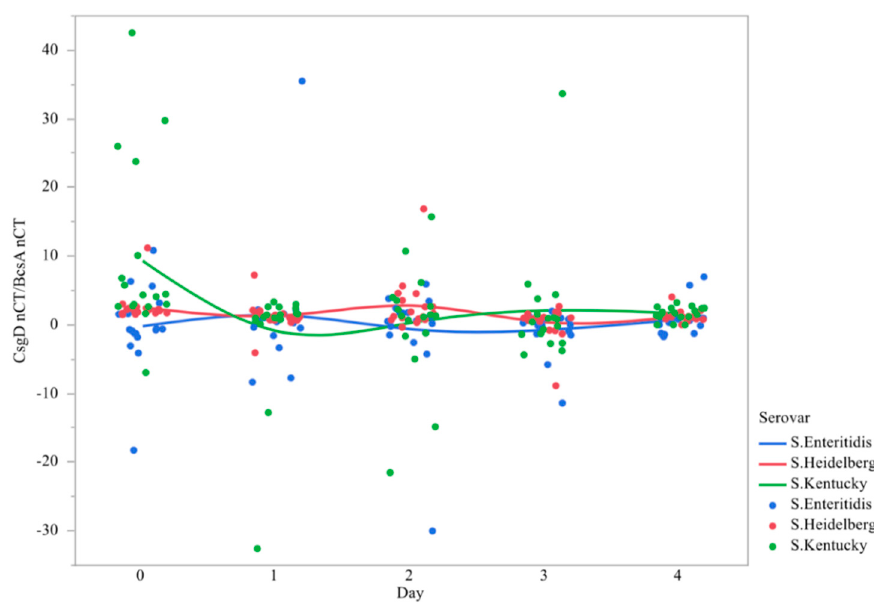
Figure 7. Comparison of changes in expression of the ratio of the genes csgD and bcsA in Salmonella serovars over time 1. qRT-PCR was performed on total RNA isolated from bacterial cultures of Salmonella as pellicles were being formed over a 96 h time period. Individual SEM was 1.450, 2.126, 1.808, 0.741, and 0.560, for S. Enteritidis, 0.516,0.472, 0.963, 0.620, and 0.209 for S. Heidelberg, and 2.960, 2.026, 2.062, 2.067, and 0.227 for S. Kentucky on day 0, 1, 2, 3, and 4, respectively. 1 N = 270, n = 18, p =0.0065.